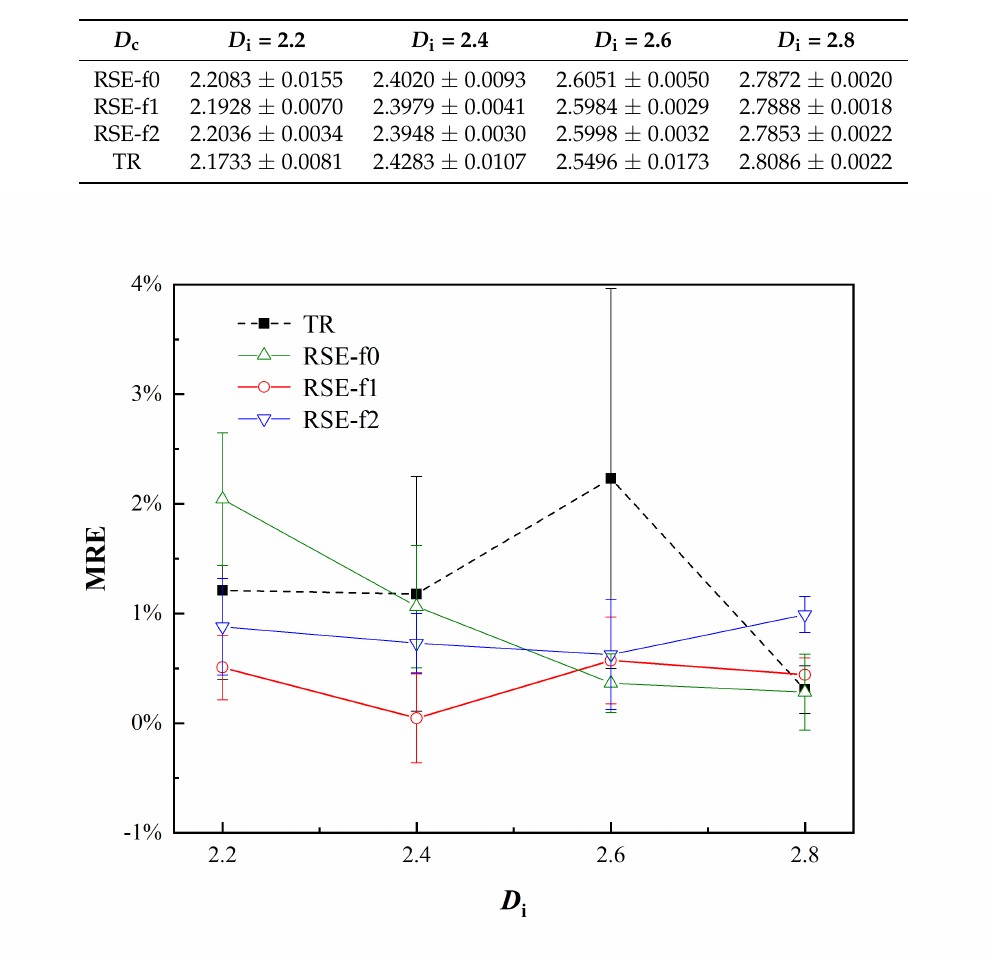
Table 2. D c values obtained with RSE-f0, RSE-f1, RSE-f2 and TR methods for the images extracted from artificial fractal surfaces with D i = 2.2, 2.4, 2.6, 2.8.